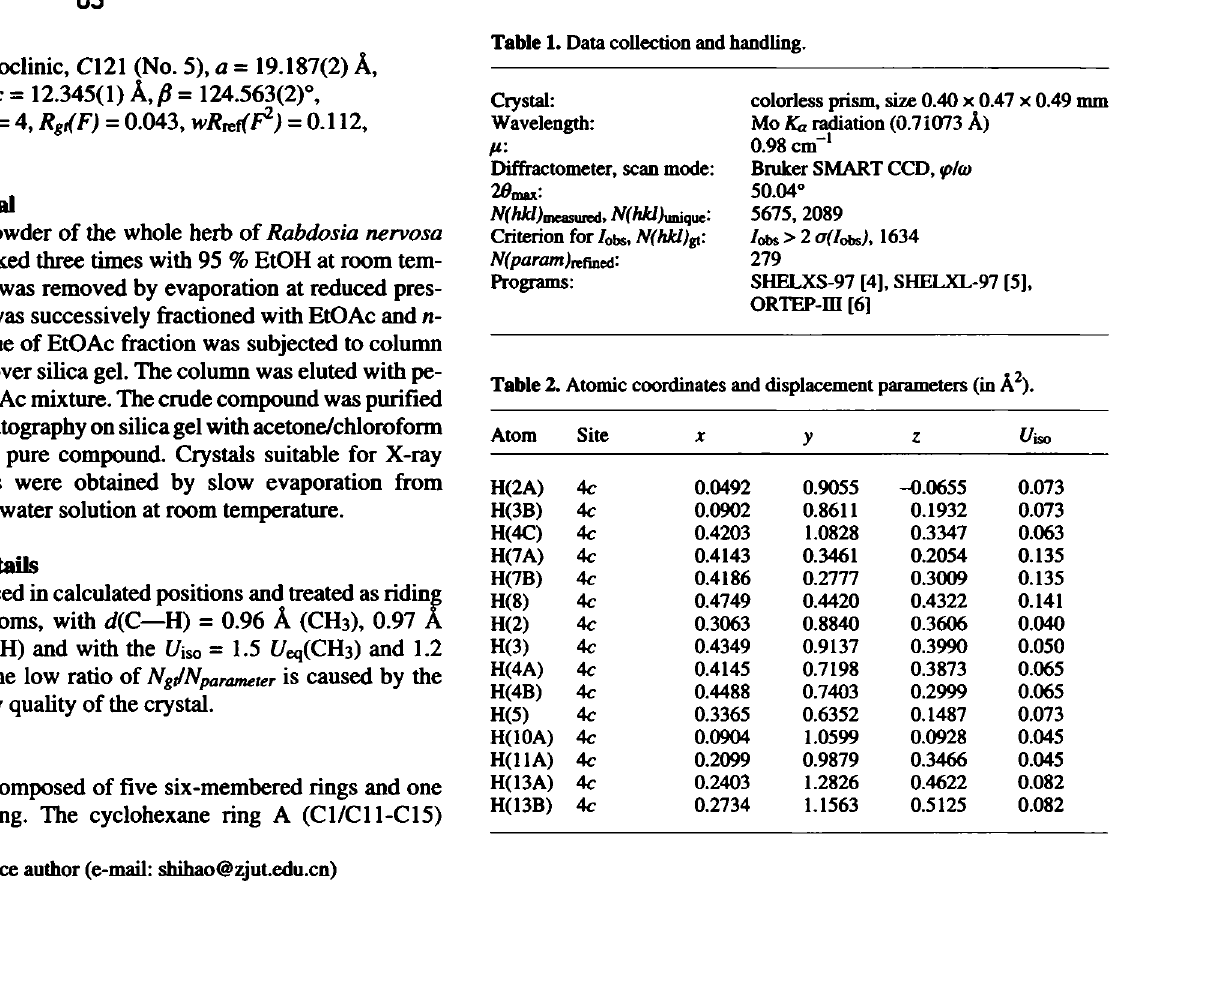
Table 1. Data collection and handling.